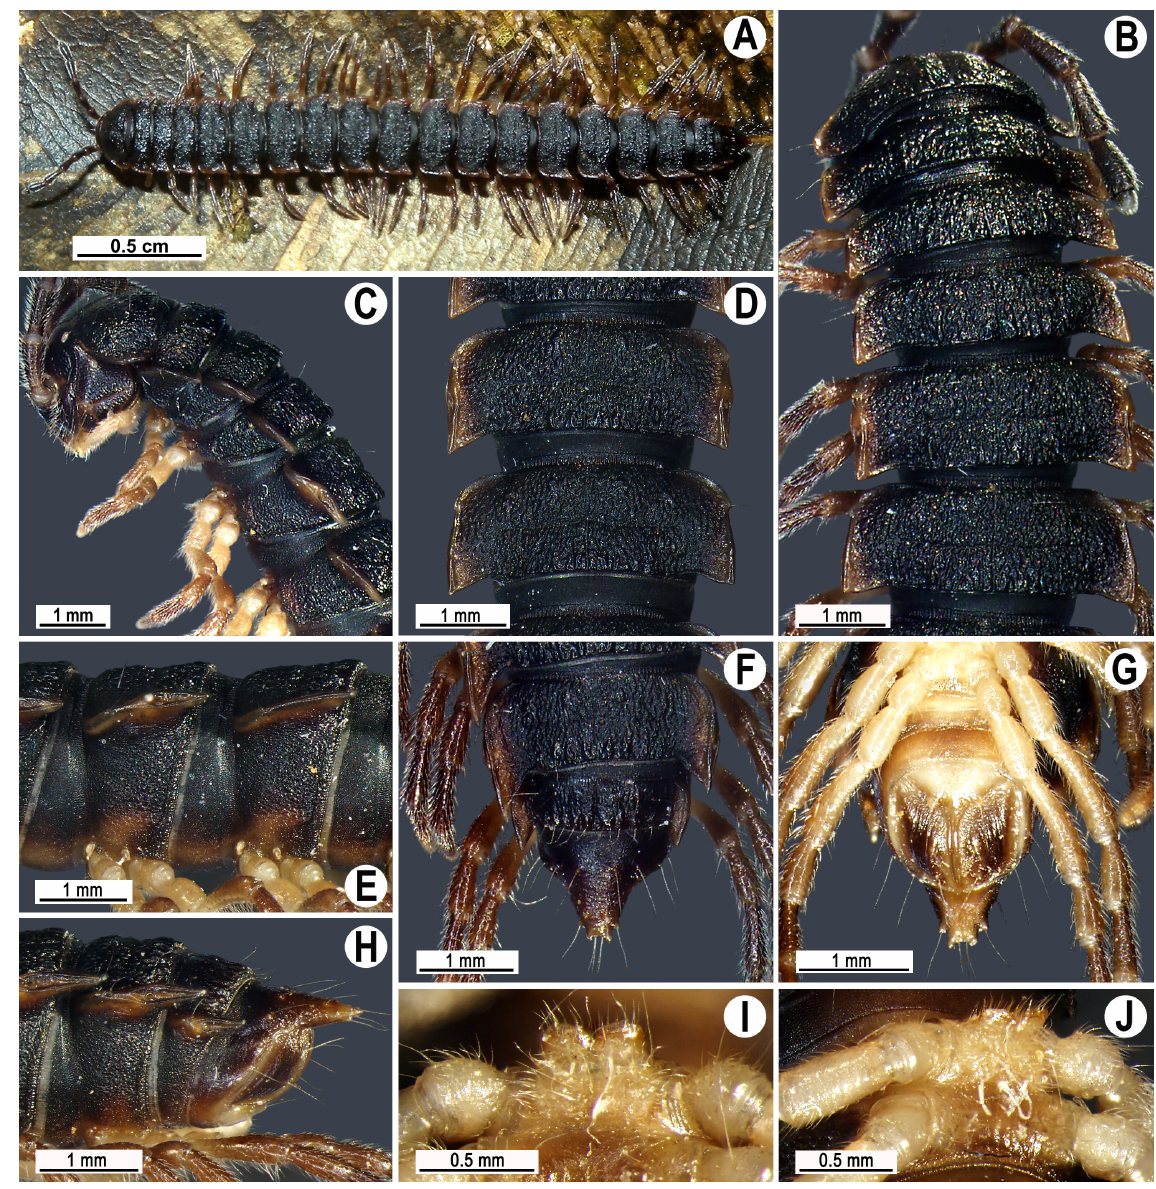
Fig. 18. Tylopus thunghaihin sp. nov., holotype, ♂. A . habitus, live coloration B–C . anterior part of body, dorsal and lateral views, respectively. D–E . Segments 10 and 11, dorsal and lateral views, respectively. F–H . Posterior part of body, dorsal, ventral and lateral views, respectively. I–J . Sternal cones between coxae 4, caudal and sublateral views,